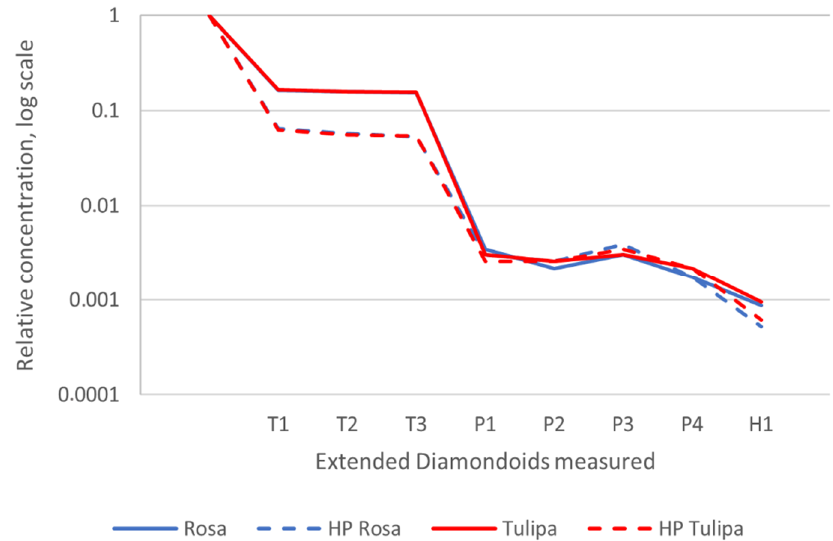
Figure 7. Fingerprints of higher diamondoids by QEDA for Rosa (red in the graphics) and Tulipa (in blue color) oils (denoted by continuous lines) and respective hydropyrolysates generated from asphaltenes (dash lines). Note: The abundances of other polymantanes are relative to that of triamantane, which is set at one [35].